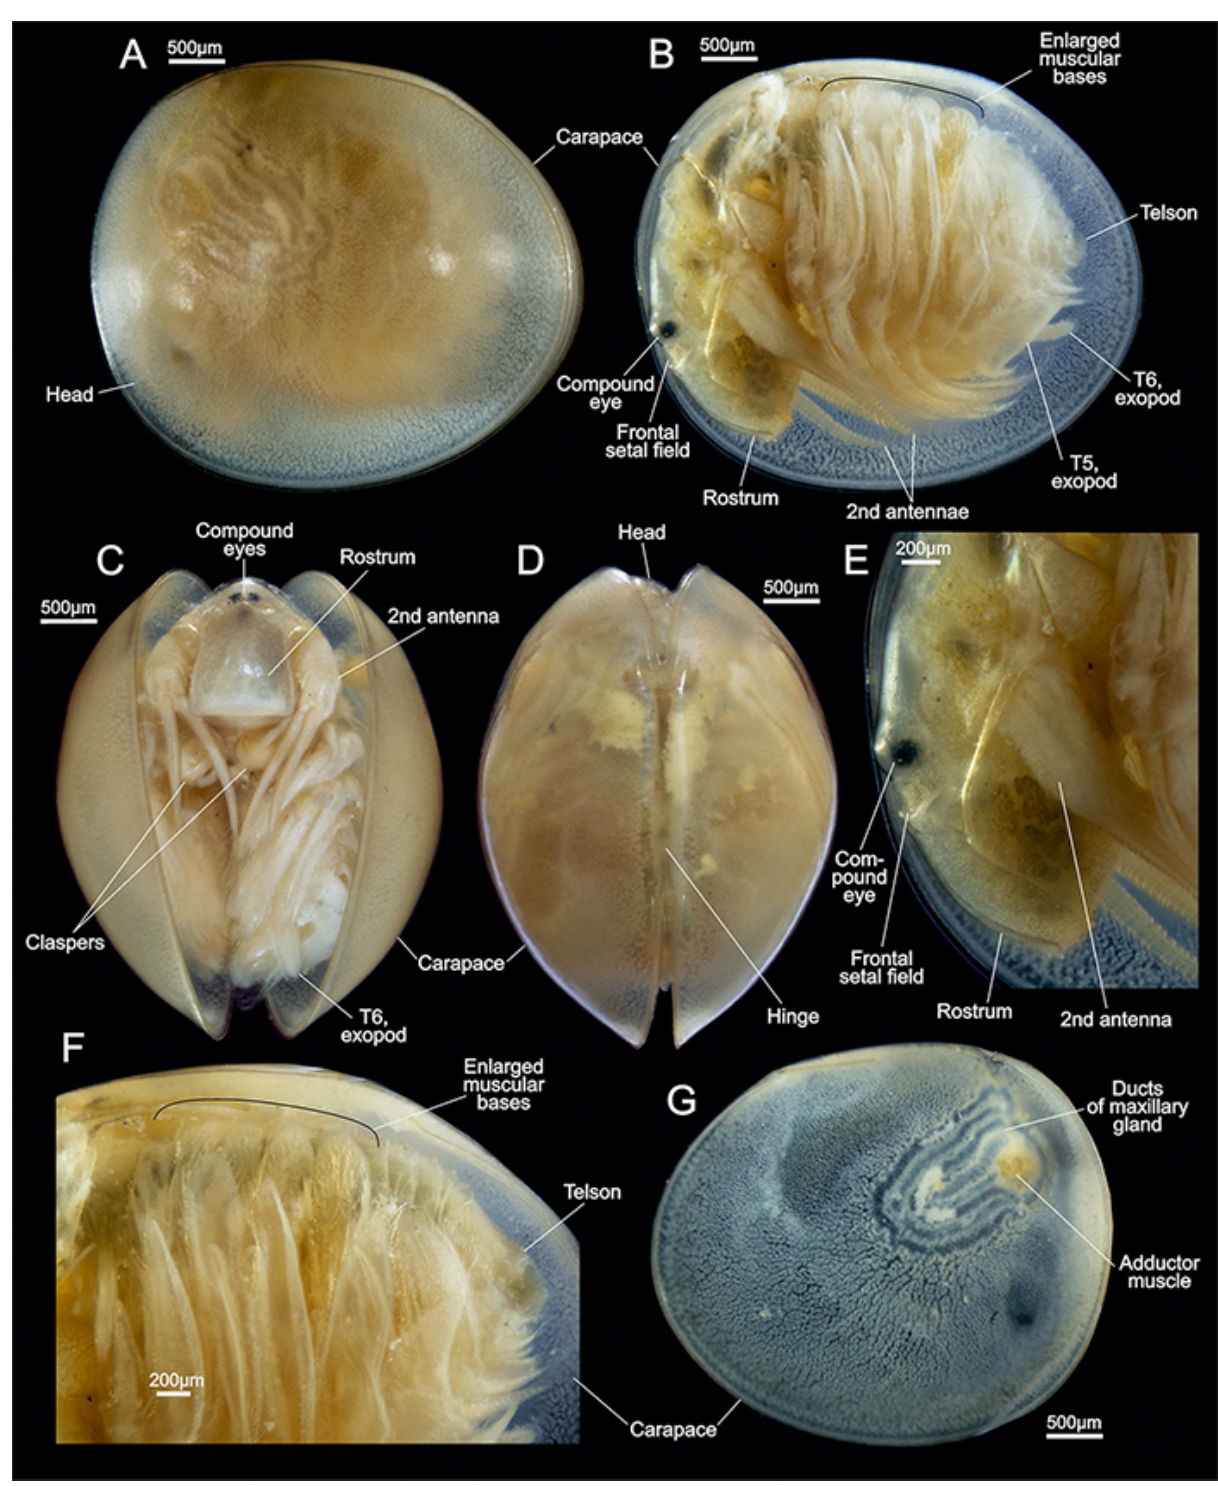
Figure 2. Lynceus grossipedia n. sp., male, stereo microscopy (holotype, NHMD-615874). A. Left lateral view, intact animal. B. Left lateral view, carapace valve removed. C. Ventral view, carapace valves apart. D. Dorsal view, carapace valves slightly apart. E. Head close-up (from B). F. Left side thoracopods, showing enlarged muscular bases. G. Carapace, left valve